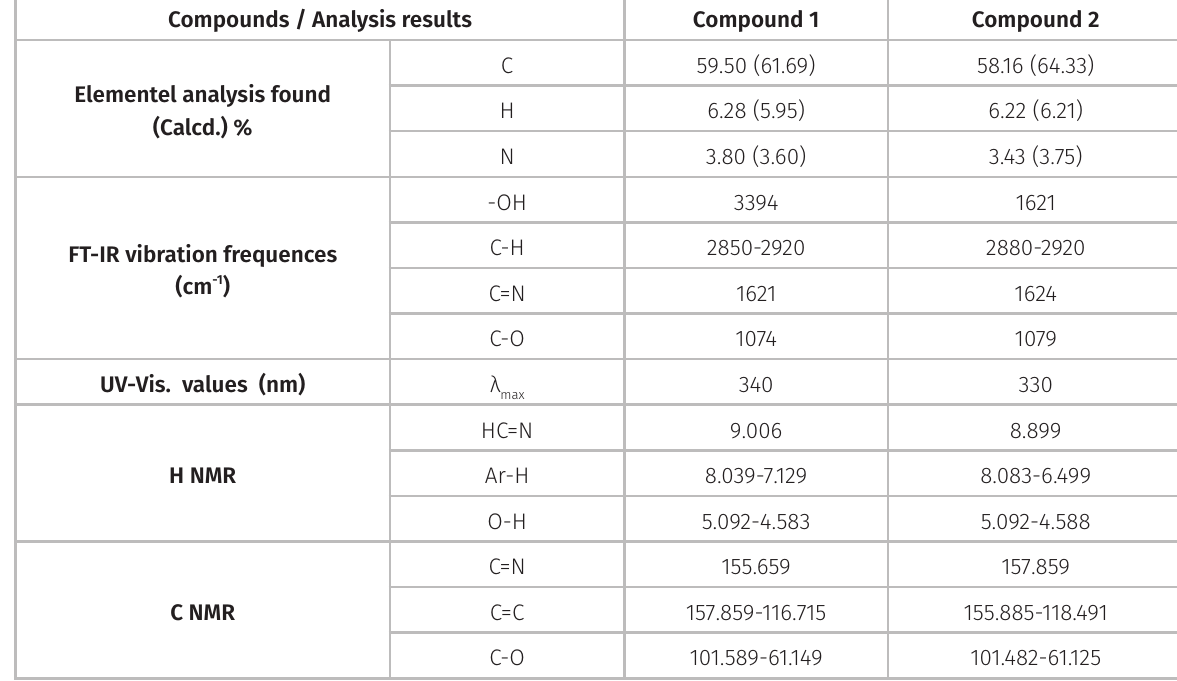
Table I. Data of elementel analysis, FT-IR, UV-vis, 1H and 13C NMR spectra of Compounds. Compounds / Analysis